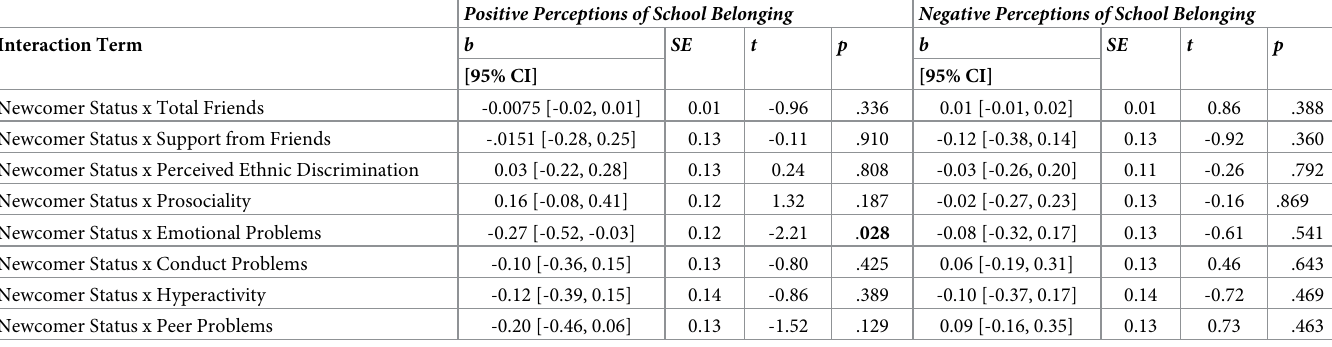
Table 5. Summary of interaction terms from moderation analyses for social correlates with positive and negative school